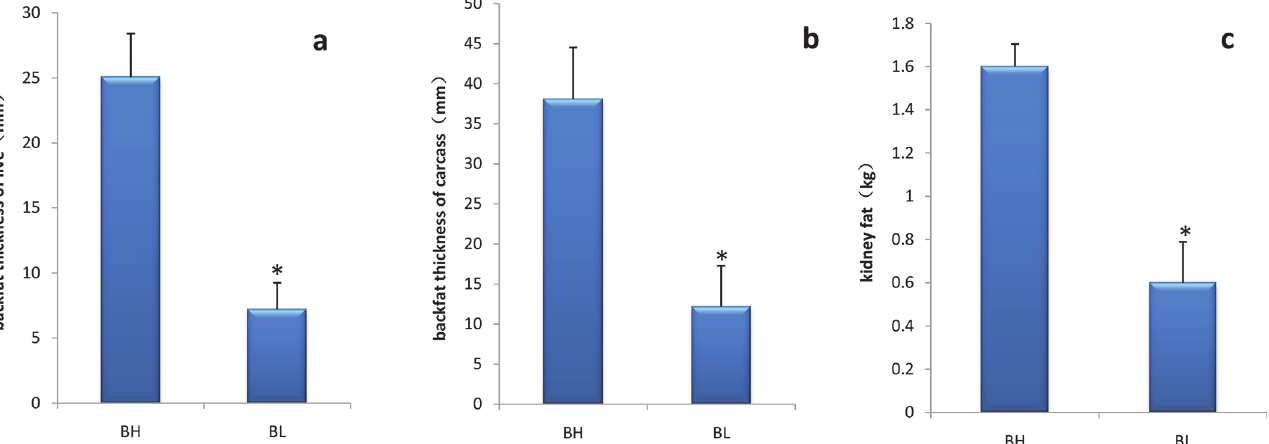
Fig 2. The traits of backfat thickness and kidney fat in BH and BL. The three traits are backfat thickness of live animals (a), backfat thickness of carcass (b) and weight of kidney fat (c). BH and BL are pigs with higher/lower thickness backfat of live using B-Ultrasound respectively. * : significantly different (p < 0.05)